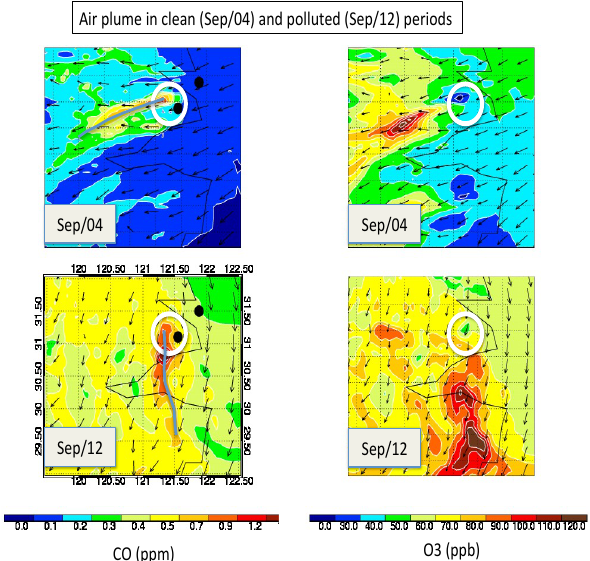
Fig. 8. The calculated horizontal distribution of CO in different me- teorological conditions. The upper panel shows a typical eastern wind condition in September 2004, resulting in a lower CO con- centrations in the Shanghai region. The lower panel shows a typical northern wind condition, producing higher CO concentration in the Shanghai